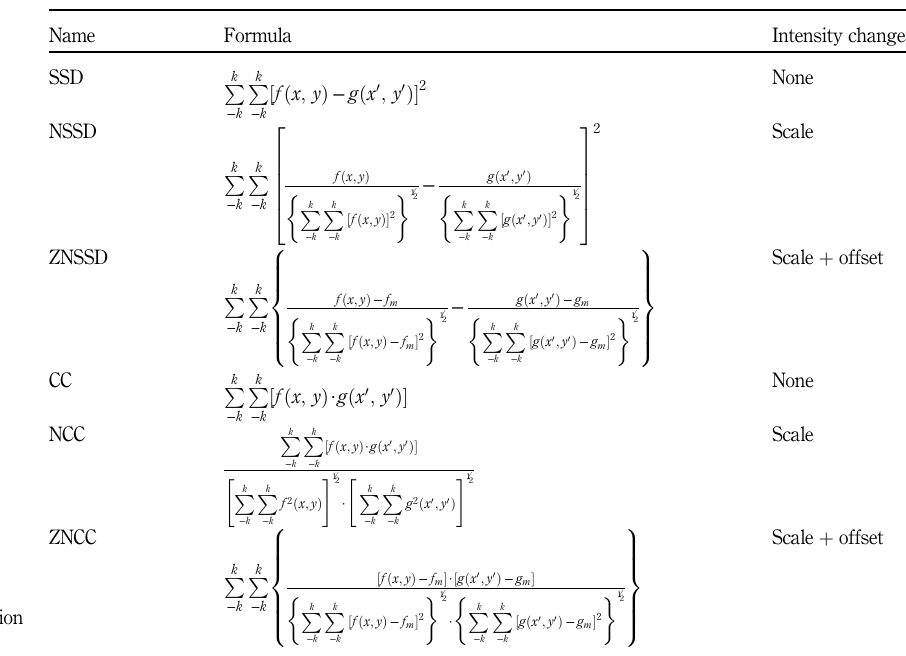
Table 1. Summary of the common optimization